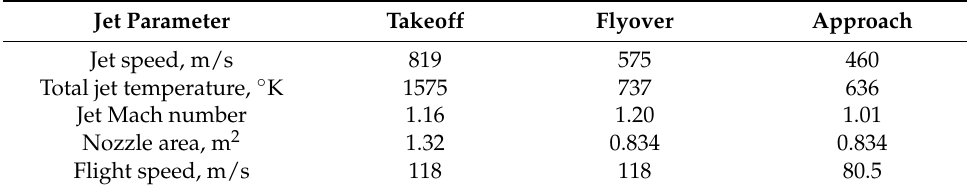
Table 1. Parameters of the jet during departure and approach for Tupolev-144.